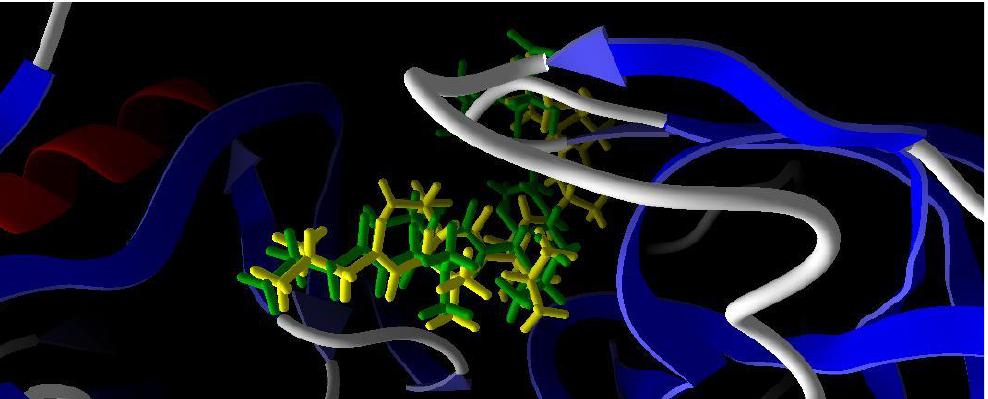
Figure 4. Comparison of its native ligand (pepstatin) (yellow) with the docking result simulation (green) by Molegro Virtual Docker (MVD) Ver.5.5 with RMSD is 1.89 Å . Based on molecular docking studies (Table 3) of pepstatin in aspartic proteinases enzyme (Saps) with the PDB ID code 2QZX, pepstatin had hydrogen bond interaction and steric interaction with a binding energy value of − 110.14 kcal/mol. Hydrogen bond interaction distance on amino acid residuals Lys 83, Gly 85, Gly 220 and Trp 221 is 2 – 3 Å . The closer the distance between hydrogen bonds, the lower the binding energy. Pepstatin also had steric interaction in several amino acid residues: Ile 12, Gly 34; Tyr 84; Asp 86, Asp 218 and Gly 220. Table 3. The Molecular docking result of micafungin and compounds 3a – e into aspartic proteinases.